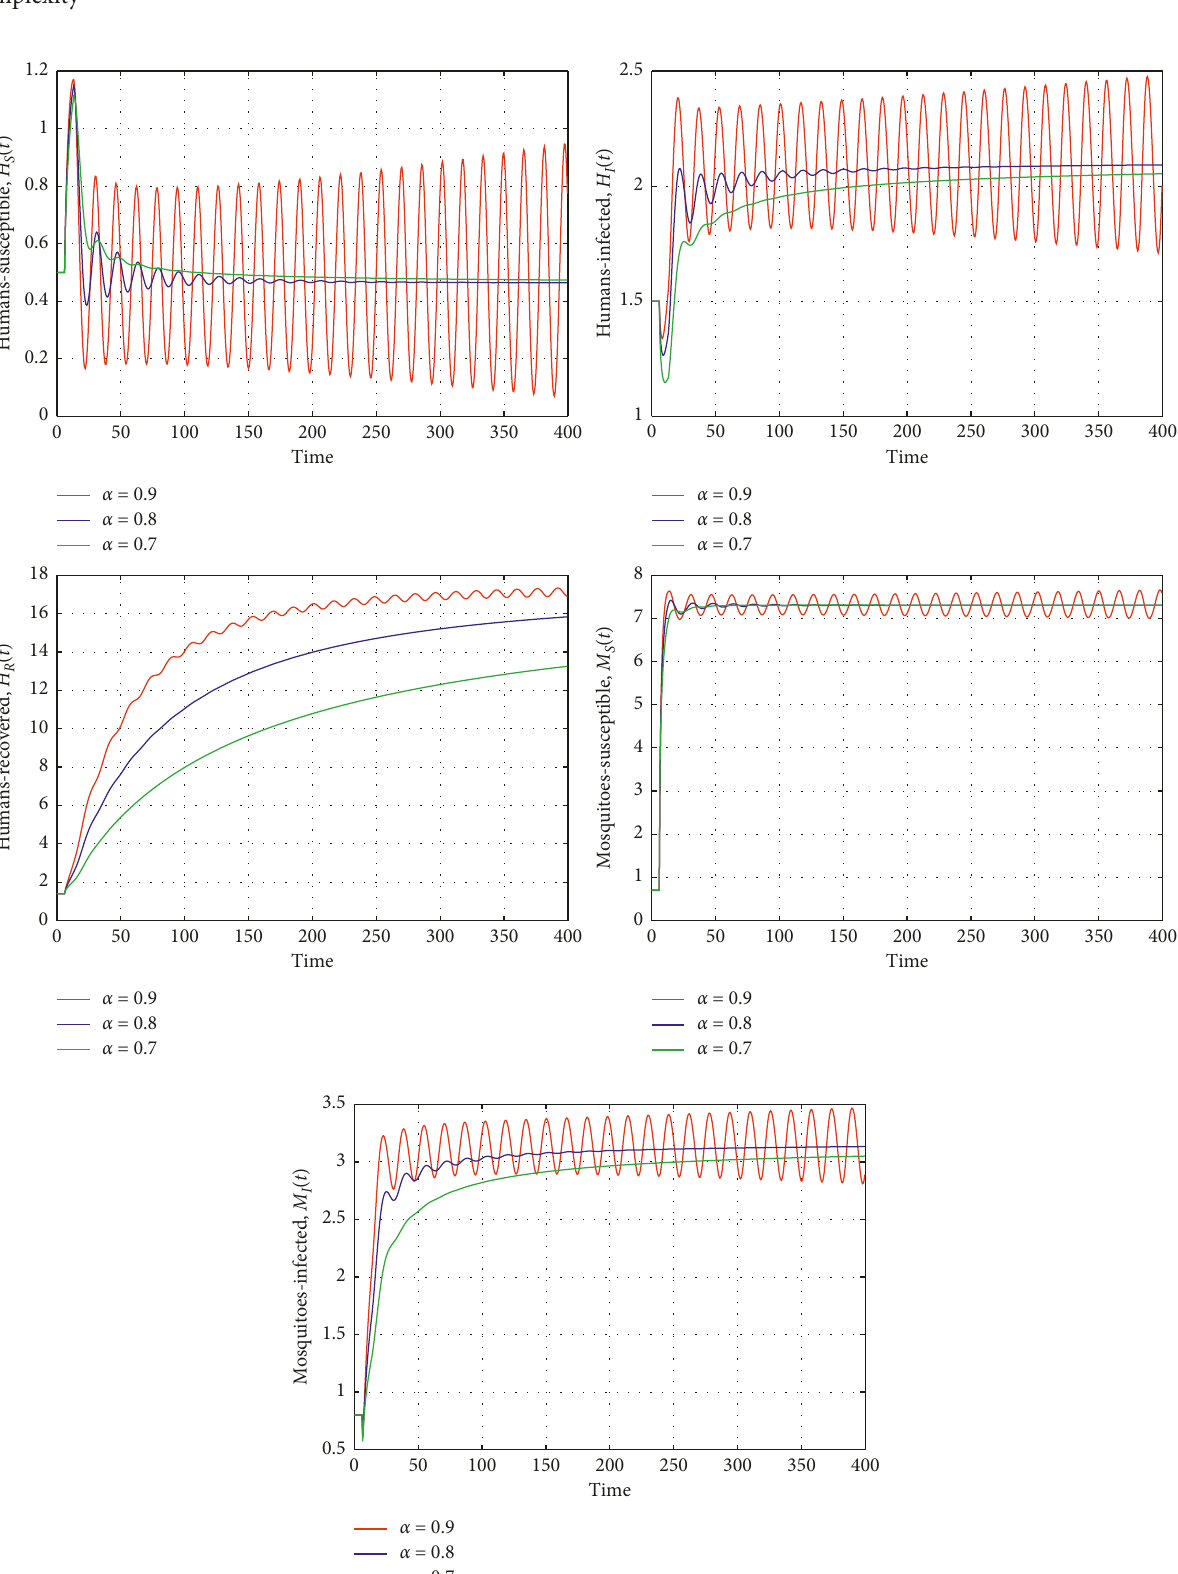
� 10 , τ � 0 . 0 , and τ 1 2 < τ ∗ and α � 0 . 8 , 0 . 7, it is asymptotically stable (blue and green 1 1